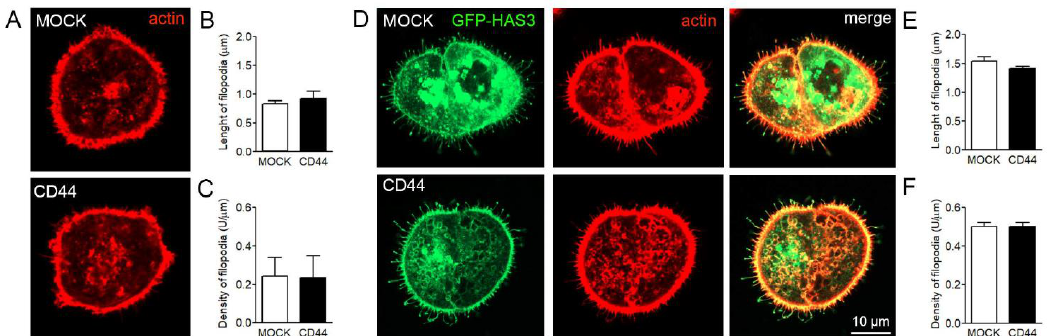
Figure 6. Effect of CD44 expression on filopodia length and density in MKN74 cells. ( A ) Examples of fixed and phalloidin-stained MKN74-MOCK and MKN74-CD44 cells and ( B ) average length and ( C )